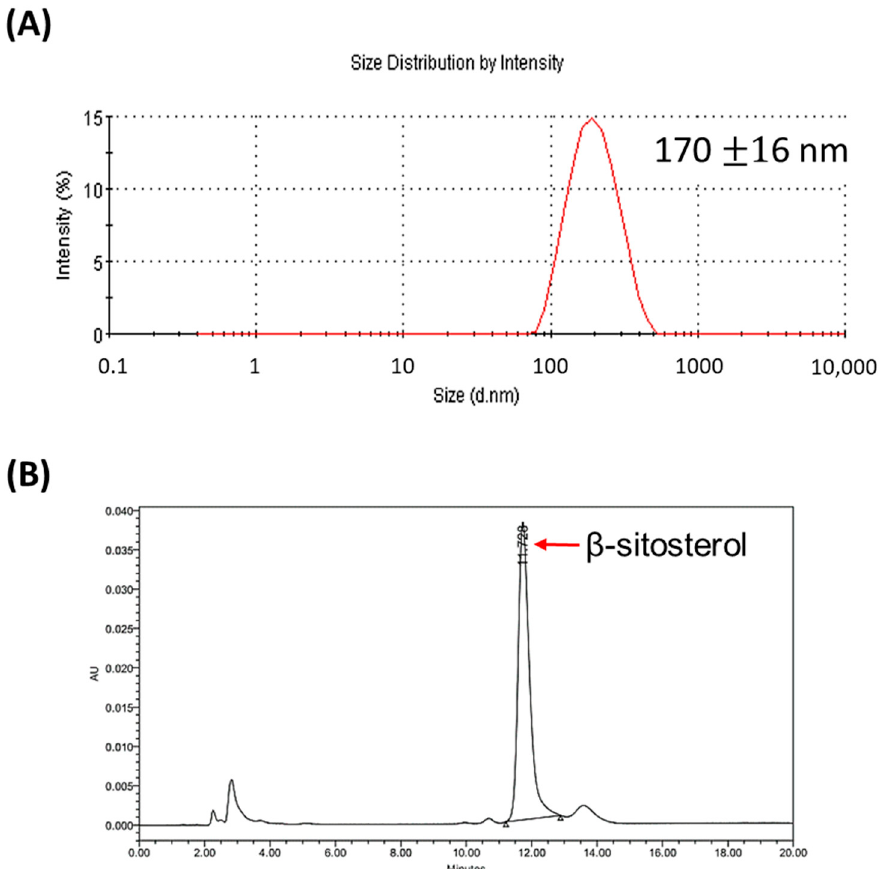
Figure 1. Characteristics of liposomal β -sitosterol (LS). ( A ) DLS analysis determined the average size of LS at 170 ± 16 nm. ( B ) The UV absorption spectrum of β -sitosterol obtained from HPLC analysis was used to calculate the concentration of β -sitosterol in LS.